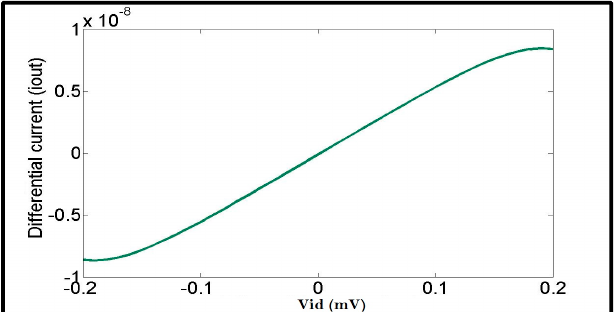
Figure 18. Differential output current of OTA.